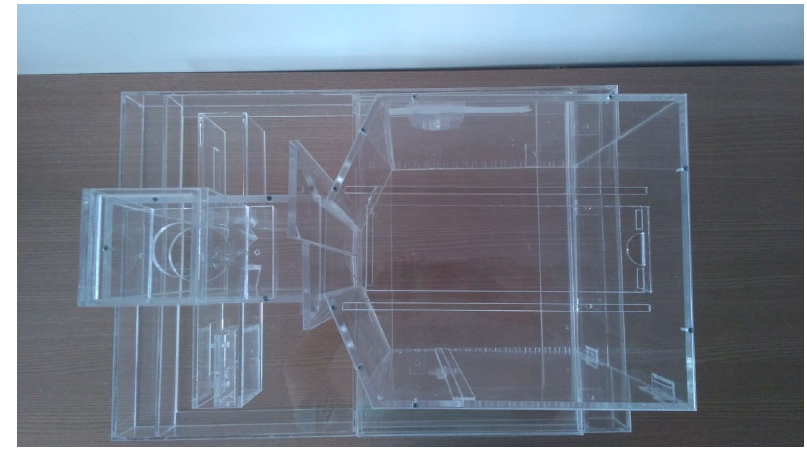
Figure 16. Behavior box top view.